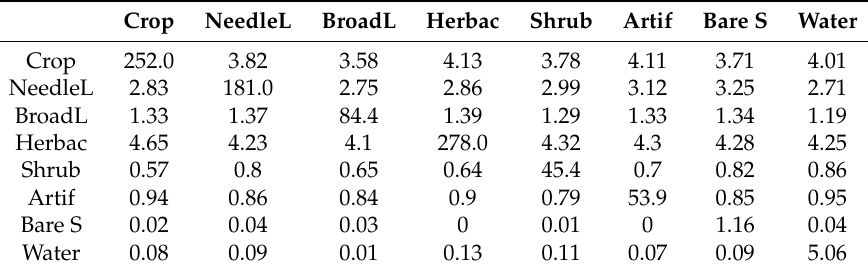
Table A8. Confusion matrix for the reference with uniform error values for each class and overall accuracy of 90%.